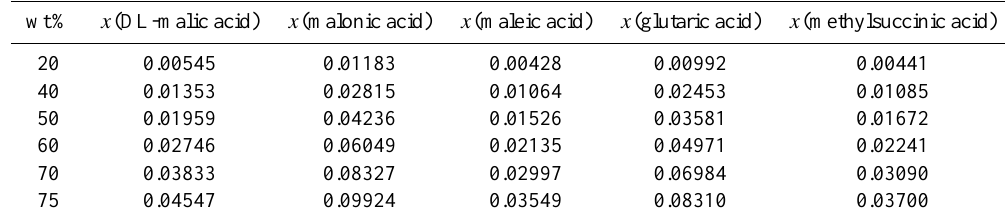
Table 15. Mixture compositions at different overall organic mass fractions of the aqueous M5 system used for total gas phase pressure measurements. Component mole fractions (x) of the dicarboxylic acids constituting the M5 mixture are given, with water accounting for the remaining